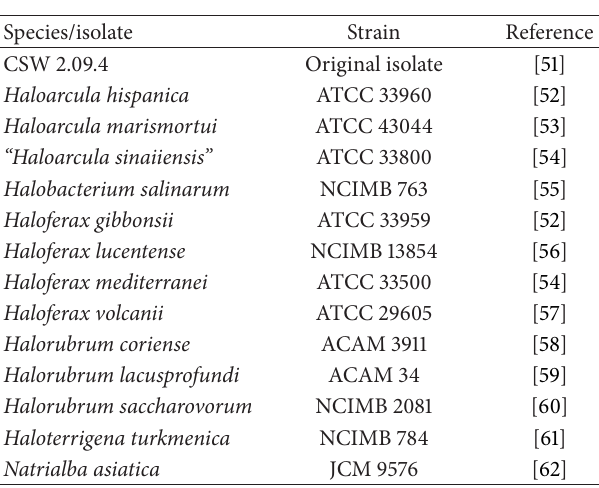
Figure 2: Growth curve of PH1. An early exponential culture of Har. hispanica in 18% (w/v) MGM was infected with virus (MOI, 50), washed to remove unbound virus, and incubated at 37 ∘ C. At regular intervals, samples were removed, the absorbance at 550 nm were measured (circles), and the number of infectious centres were determined by plaque assay (squares). Error bars represent one standard deviation of the average